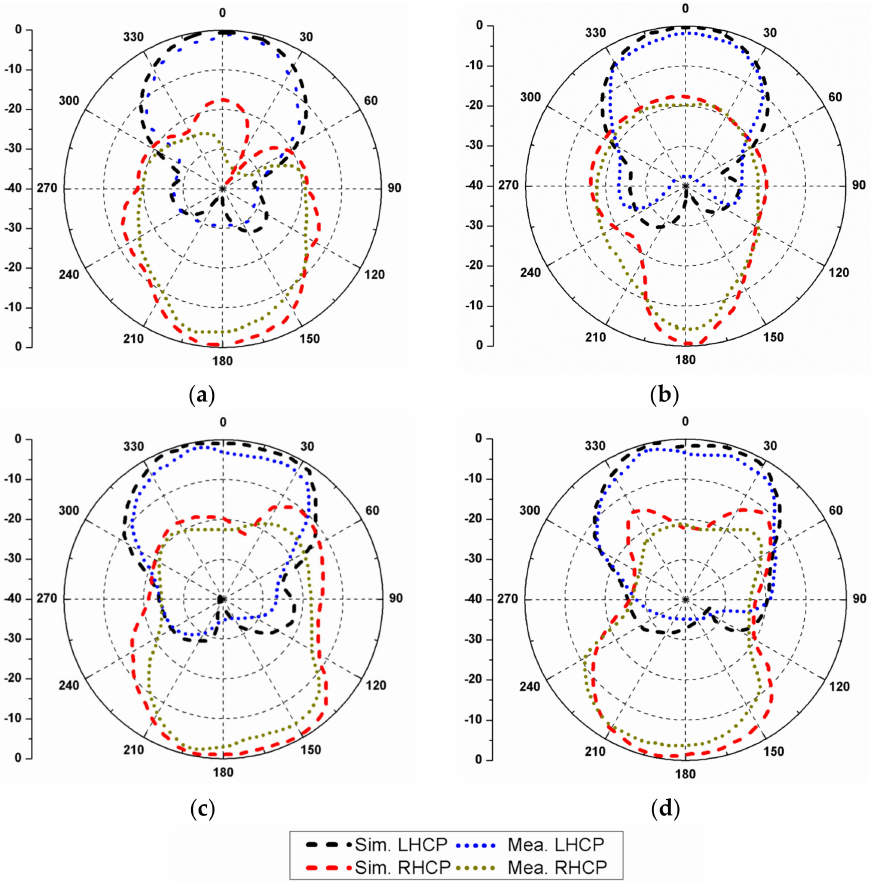
Figure 14. Simulated and measured radiation patterns of the stacked MIMO antenna: ( a ) XZ -plane/4.2 GHz; ( b ) YZ -plane/4.2 GHz; ( c ) XZ -plane/4.8 GHz; ( d ) YZ -plane/4.8